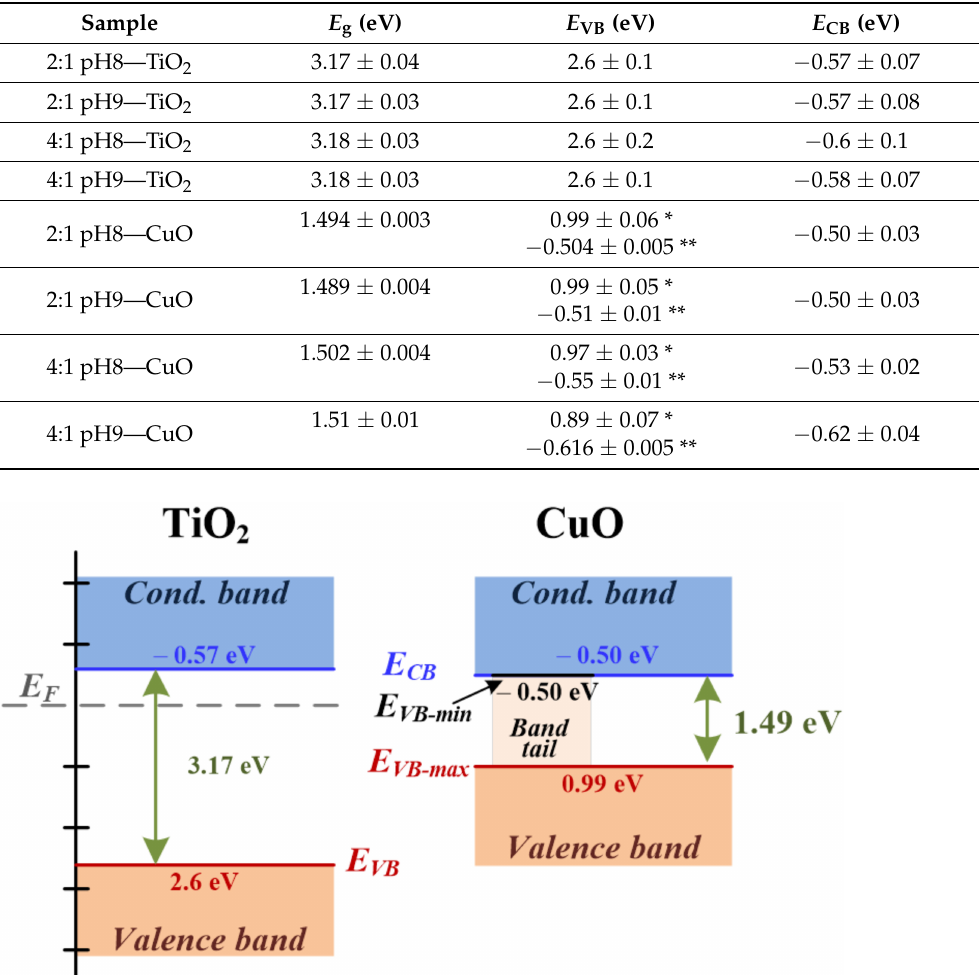
Table 1. Values of E g , E VB and E CB for all powders. The values labeled by * and ** correspond to the E VB-max and E VB-min , respectively, for the CuO.